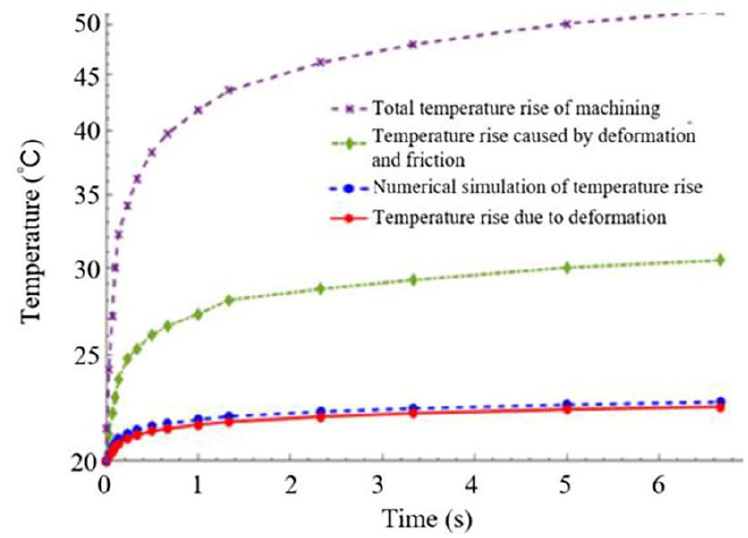
Figure 20. Temperature measured in the experiments.